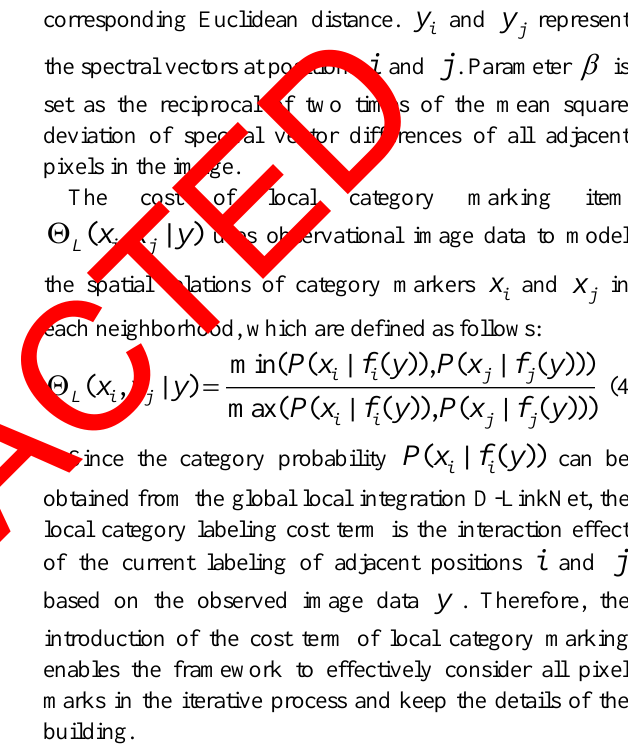
 is used to The binary potential energy ) ,, ( yyx iii construct the relationship between the current node and its neighborhood node, which makes the spatial interaction of local pixels can be considered in building